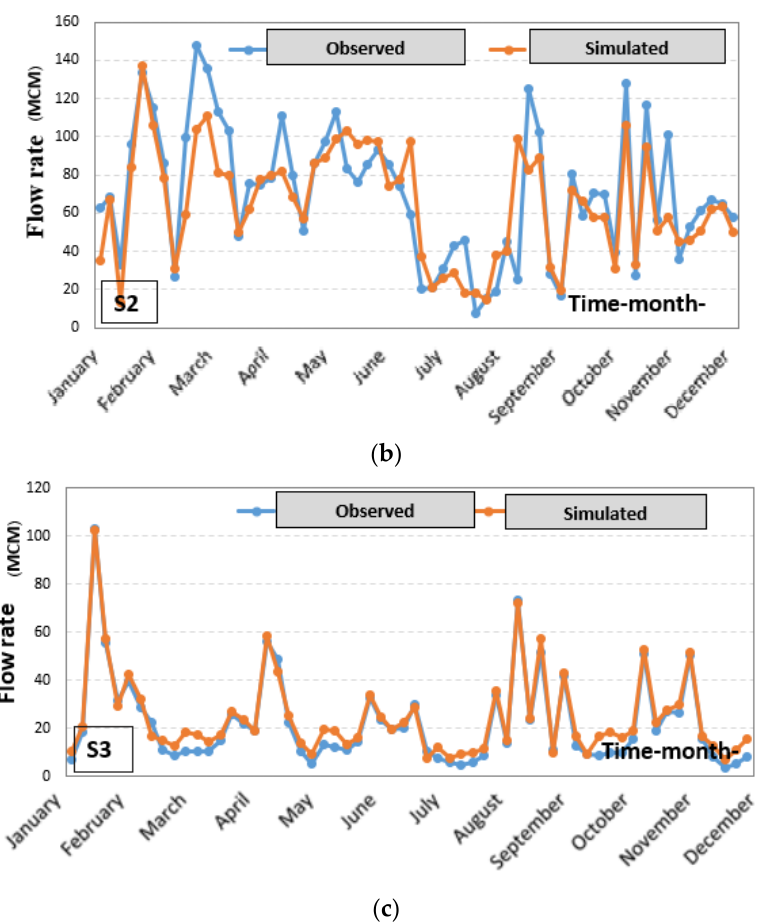
Figure 11. Parameter Q for the QUAL2KW model during calibration for stations ( a ) S1; ( b ) S2; and ( c ) S3.